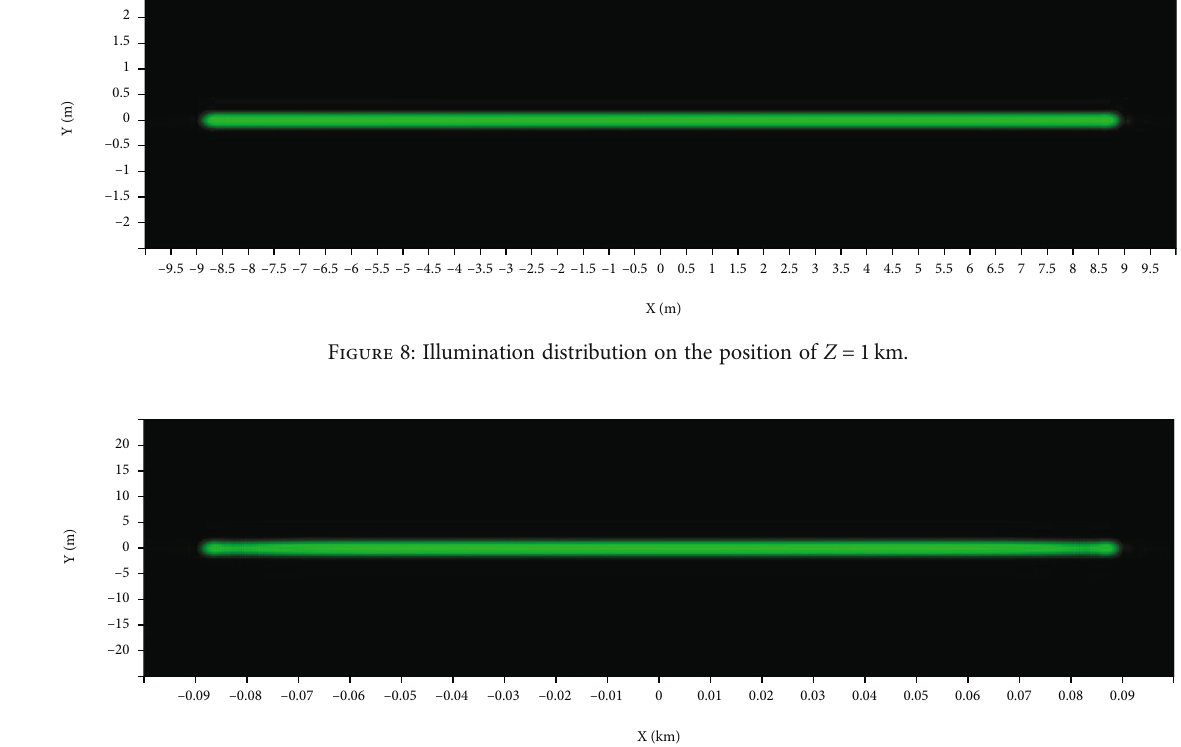
Figure 9: Illumination distribution on the position of Z = 10